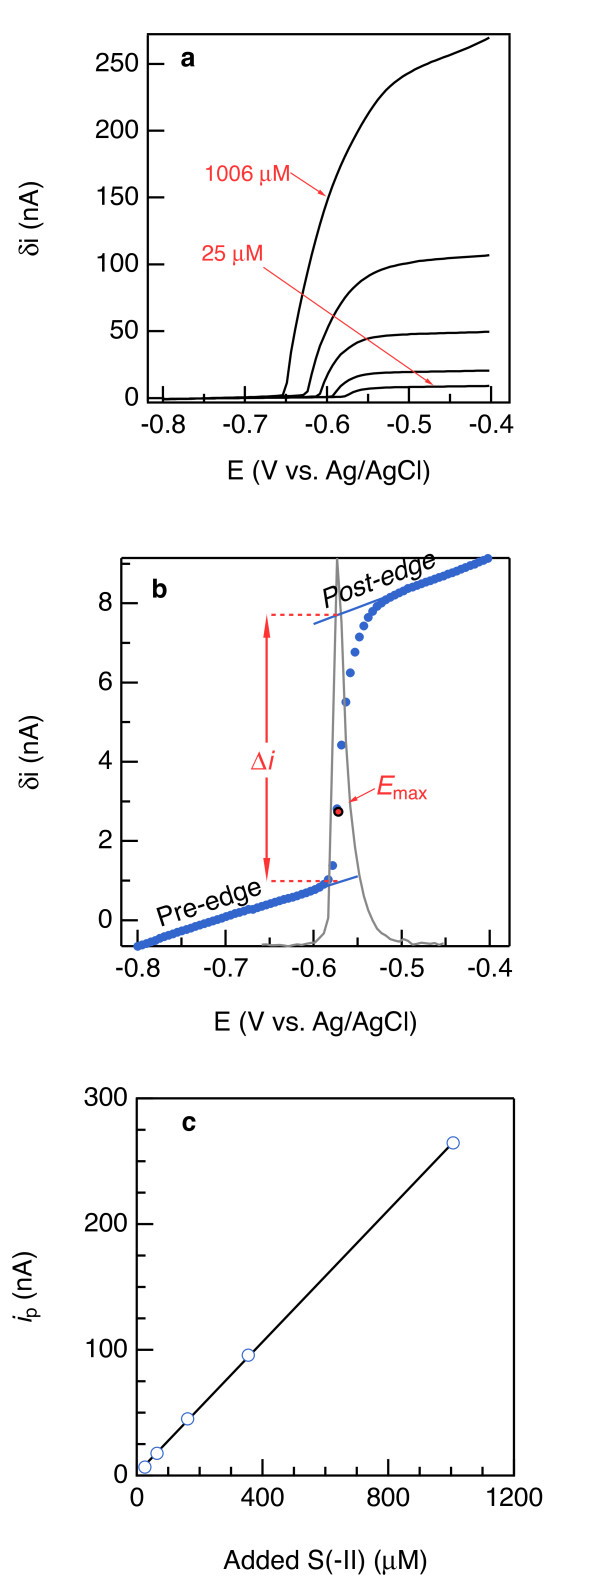
 (a) Current (i) versus potential (E) relationships to quantify S(-II) with normal pulse voltammetry. (b) The dots represent the pulse current δ, in nanoamperes, measured in artificial seawater containing 25.4 μM S(-II). The solid line is its first derivative, the maximum of which locates Emax at which to calculate the current Δi on the basis of the coefficients of the pre- and post-edge regressions before and after the jump in i upon Hg oxidation by S(-II), which is then plotted against added S(-II) concentration to calibrate the electrode (c; see Table 1 for calibration slopes).